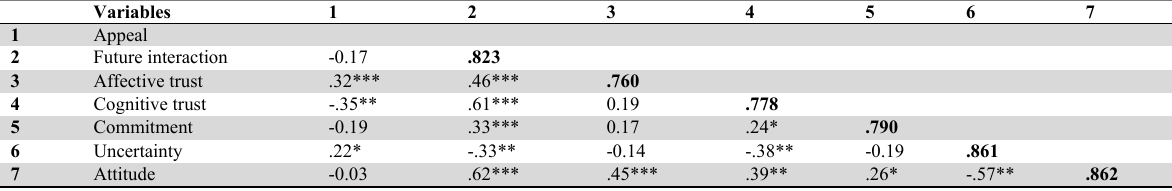
Zero-order correlations among study variables (N = 254).